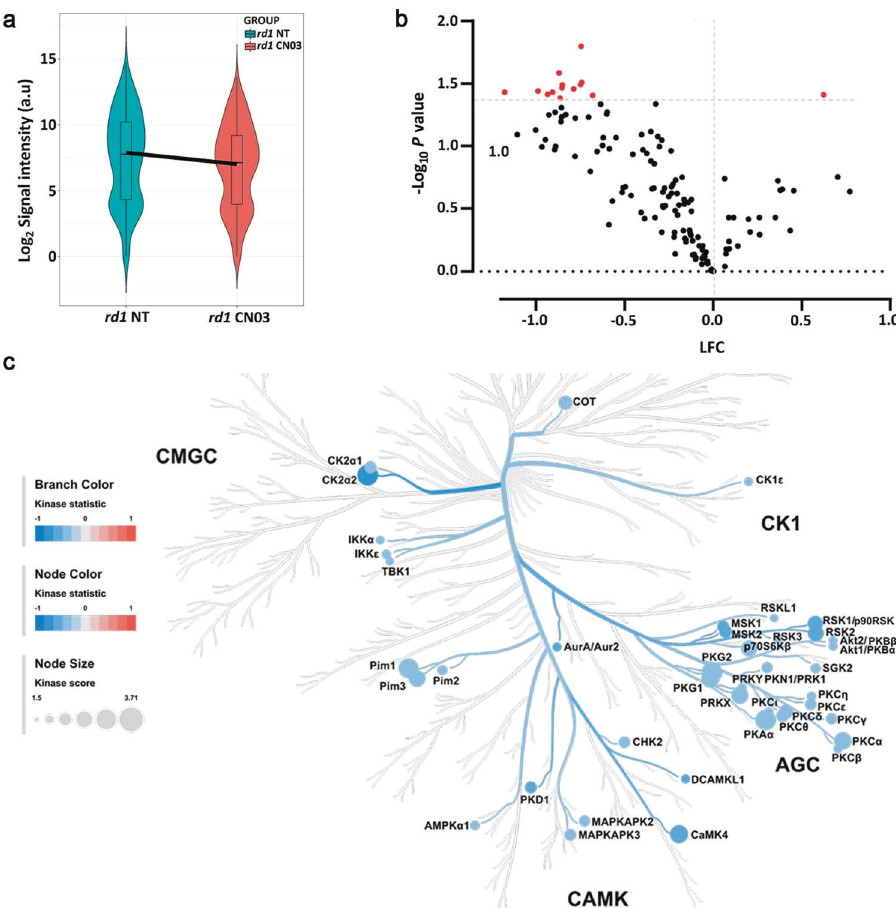
Fig. 3 Serine/Threonine Kinase (STK) activity in response to PKG inhibition in retinal explants. Retinal explant cultures were either non- treated (NT) or treated with 50 µM CN03 ( rd1 NT, n = 8; rd1 CN03, n = 10). The kinase activity of retinal explant lysates was measured on PamChip ® Serine/Threonine kinase (STK) arrays. a Violin plot showing the global phosphorylation of peptides on the PamChip ® STK array as Log 2 signal intensity and their intensity value distribution, when comparing rd1 NT to rd1 CN03 treated explants. The thick line is connecting the average values of each group. b Volcano plot representing Log Fold Change (LFC) and -Log 10 p value for peptide phosphorylation. Red dots indicate signi fi cantly changed phosphopeptides with p value < 0.05 and black dots represent phosphopeptides with no signi fi cant alteration in phosphorylation. c The high-ranking kinases are visualized in a kinome phylogenetic tree, where branch and node color are encoded according to the kinase statistic, with values < 0 (in blue) representing lower kinase activity in rd1 retinal explants treated with CN03. The node size is encoded by the kinase score, that ranks kinases based on their signi fi cance and speci fi city in terms of sets of peptides used for the corresponding DNA topoisomerase 2- α (TOP2A) expression was restricted to the GCL.